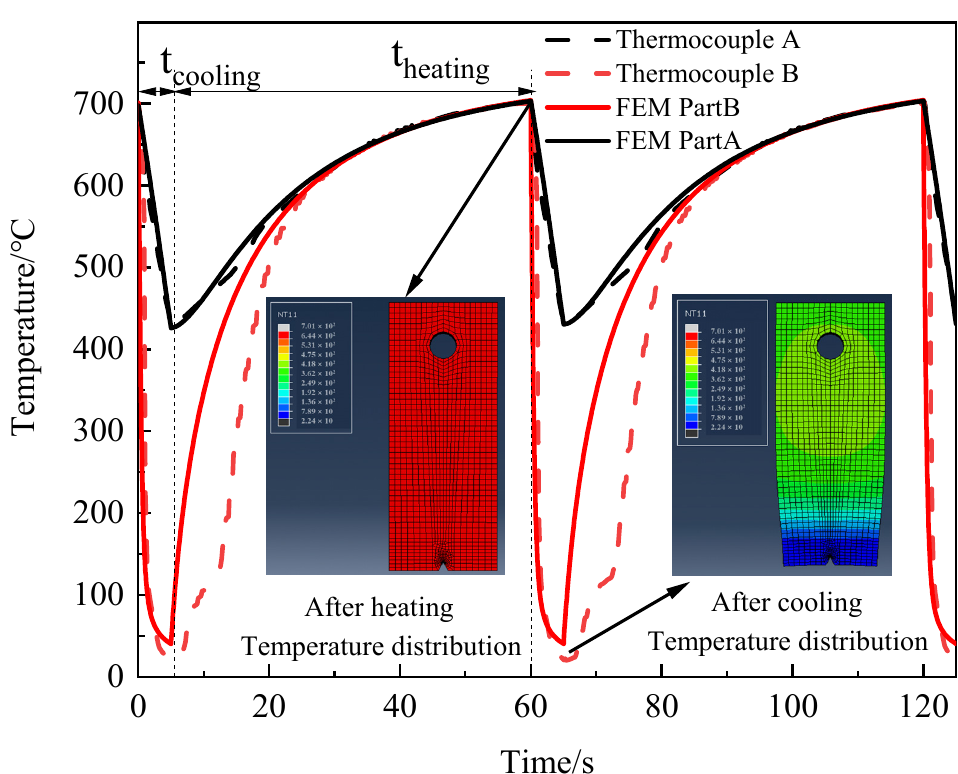
Figure 2. The time-temperature curve for cyclic loading at the notch and 25 mm away from the notch.